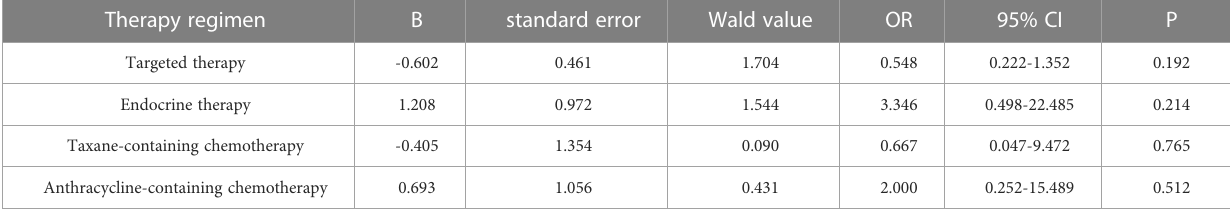
TABLE 4 Logistic multivariate analysis results of treatment regimens on changes in ER expression. Therapy regimen